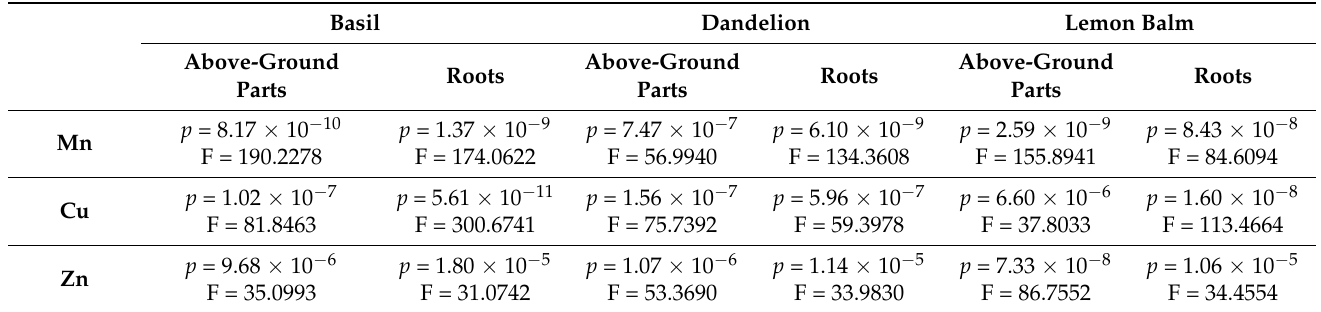
Table 2. The one-way ANOVA for manganese, copper, zinc contents in plant across the soil pH. Critical Snedecor’s F value is Fcryt = 3.88533.